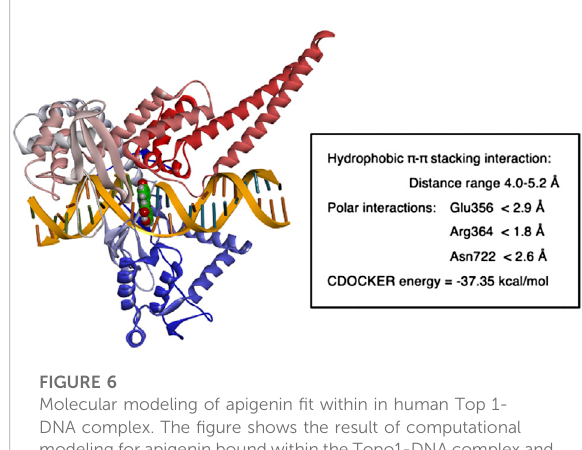
FIGURE 6 Molecular modeling of apigenin fi t within in human Top 1- DNA complex. The fi gure shows the result of computational modeling for apigenin bound within the Topo1-DNA complex and key interaction